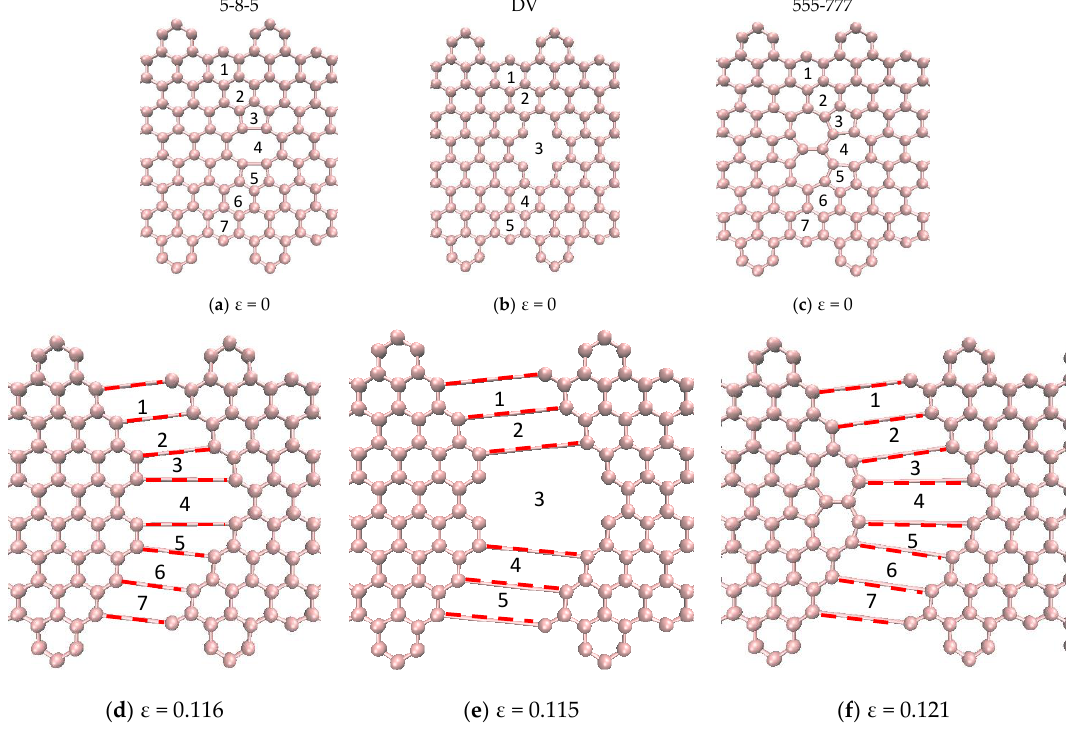
Figure 11. Failure patterns and related atoms and bonds of 5-8-5, DV and 555-777 defects.